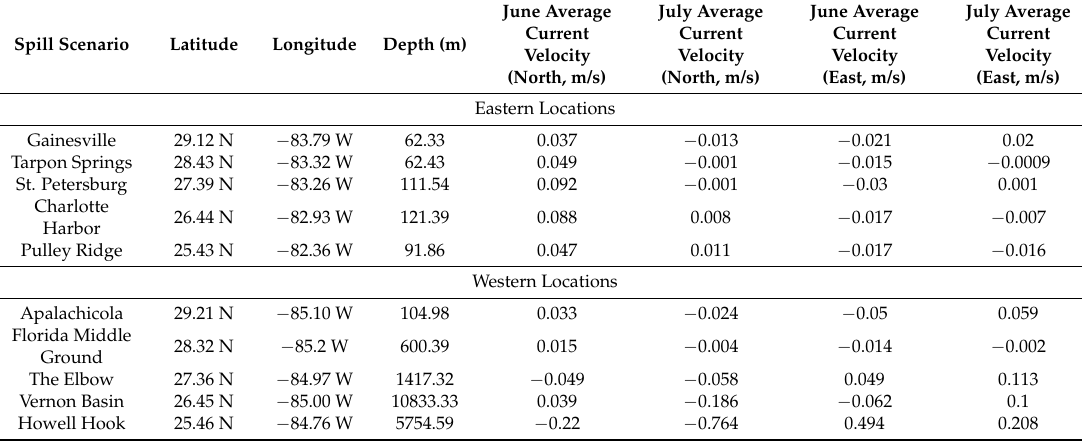
Table 1. Geographic location, depth, and the average monthly current speed within a 25 mile radius around the spill location. Negative numbers represent current directions opposite to the direction noted in the column headers. For example, negative numbers for the June and July average current velocity north would mean the dominant current direction is